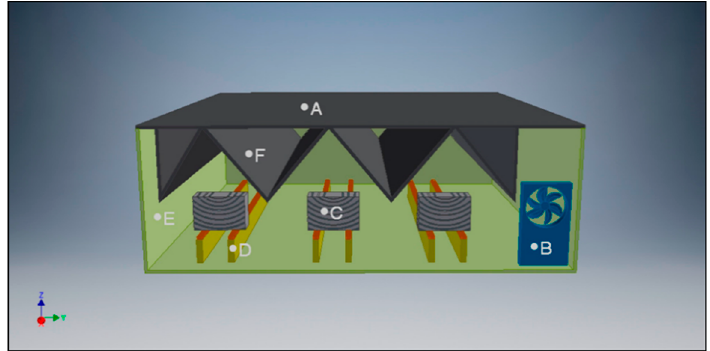
Figure 2. Scheme of the humidification chamber. A: lid, B: fan, C: wooden specimen, D: support, E: cuvette and F: baffle.